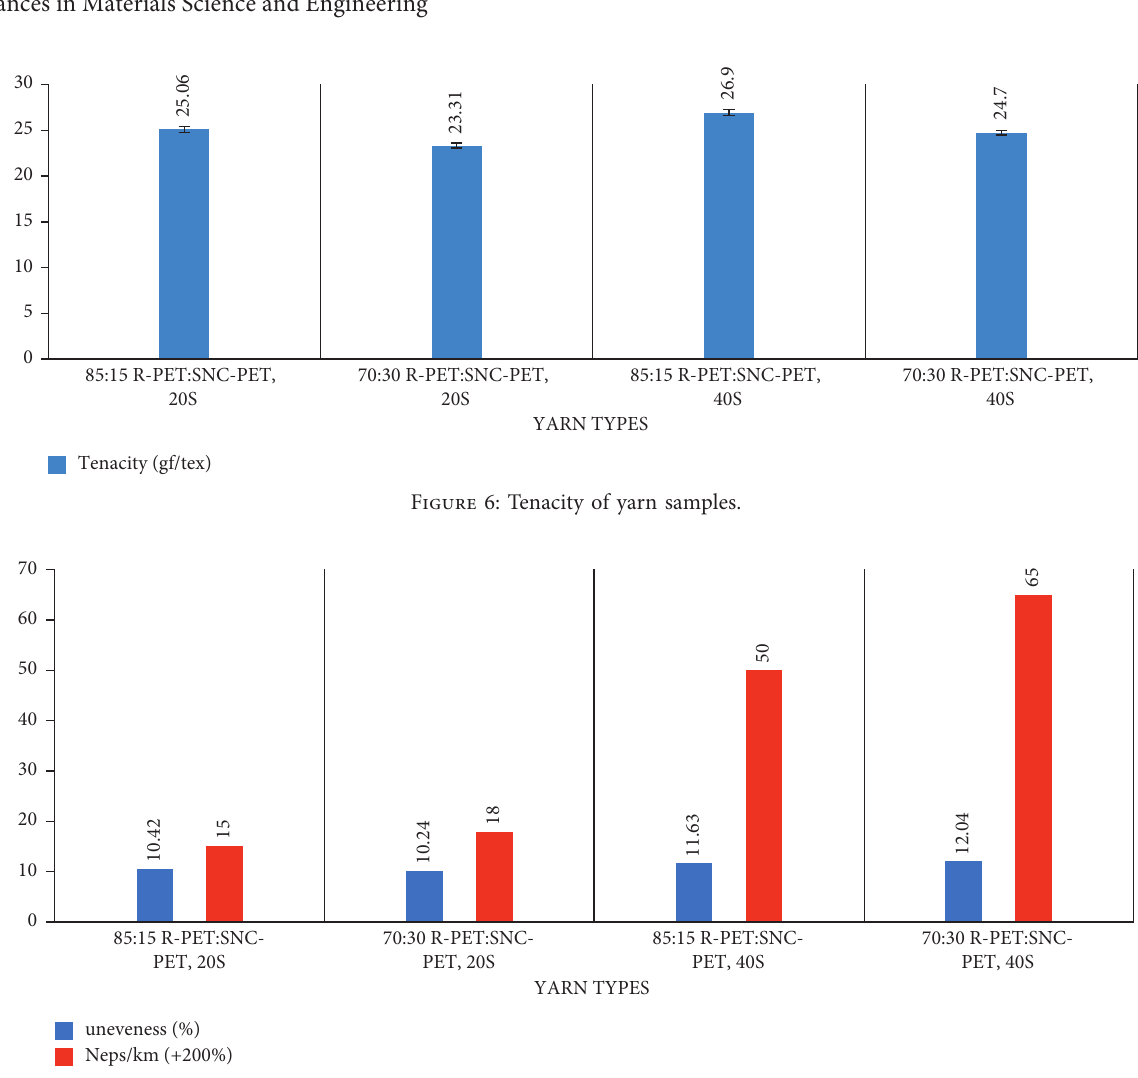
Figure 7: NEP counts (+200%) and unevenness of yarn samples. Table 6: Tensile and evenness properties of